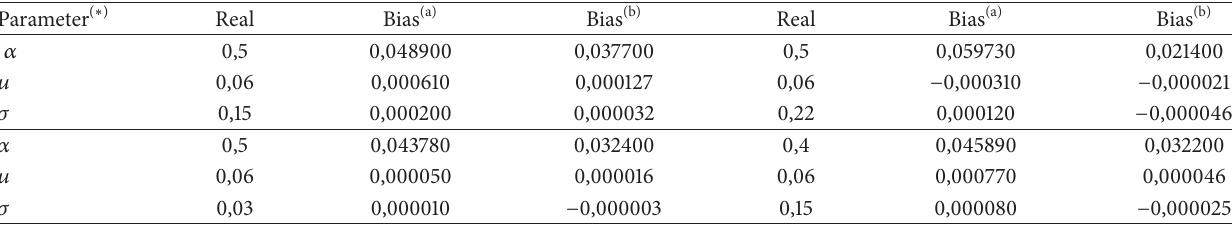
Table 6: Comparison of Durham and Gallant, and proposed